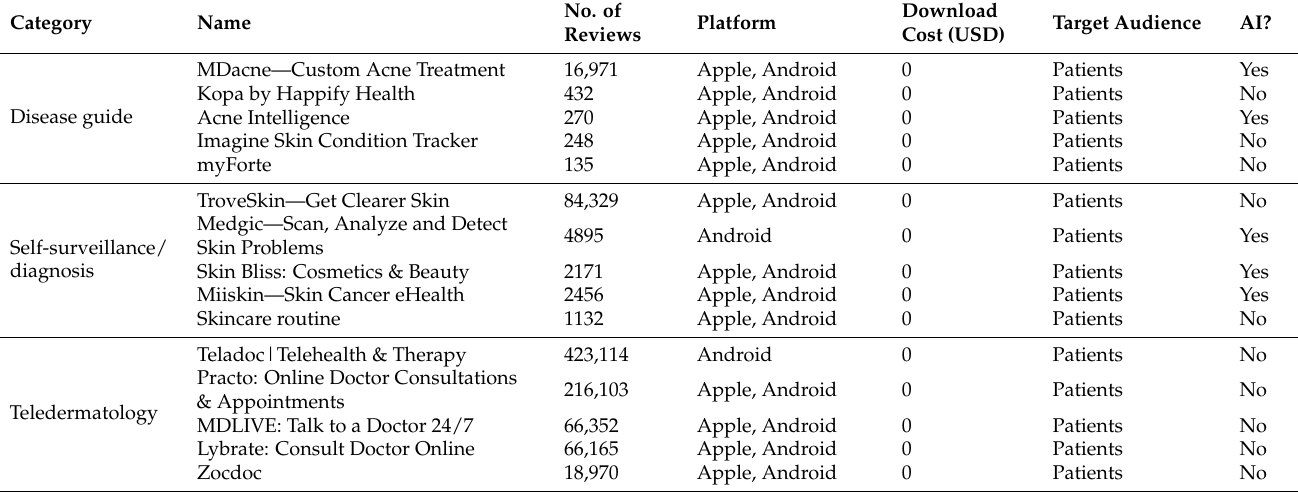
Table 1. Characteristics of the top apps per category based on number of reviews for categories with 50 or more